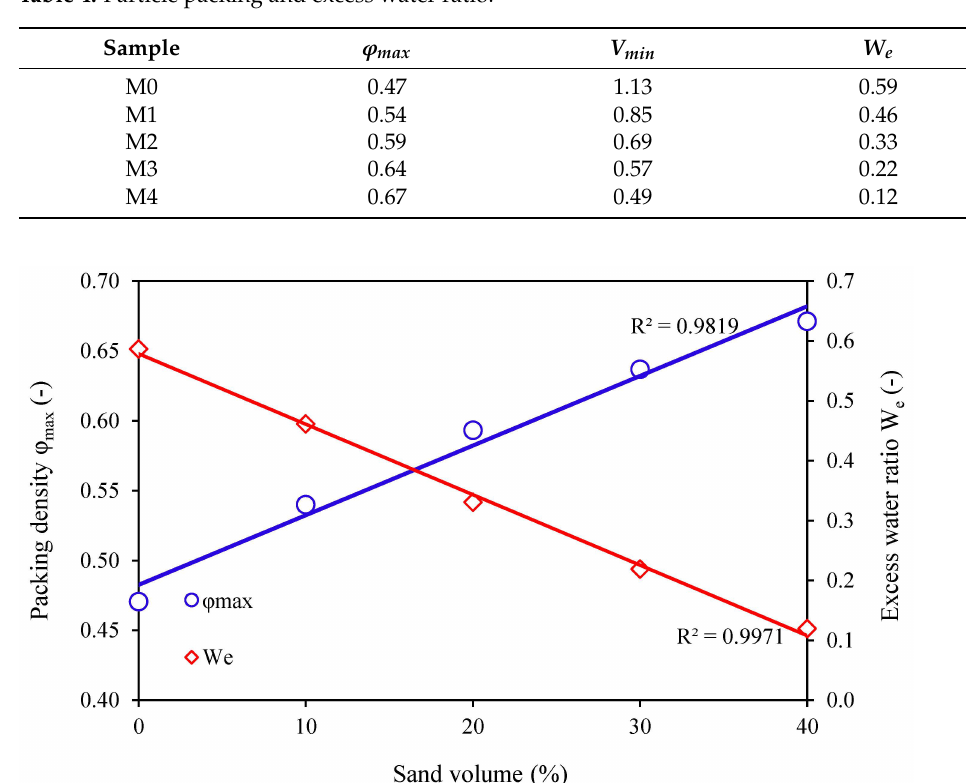
Figure 6. Packing density and excess water ratio as a function of sand volume